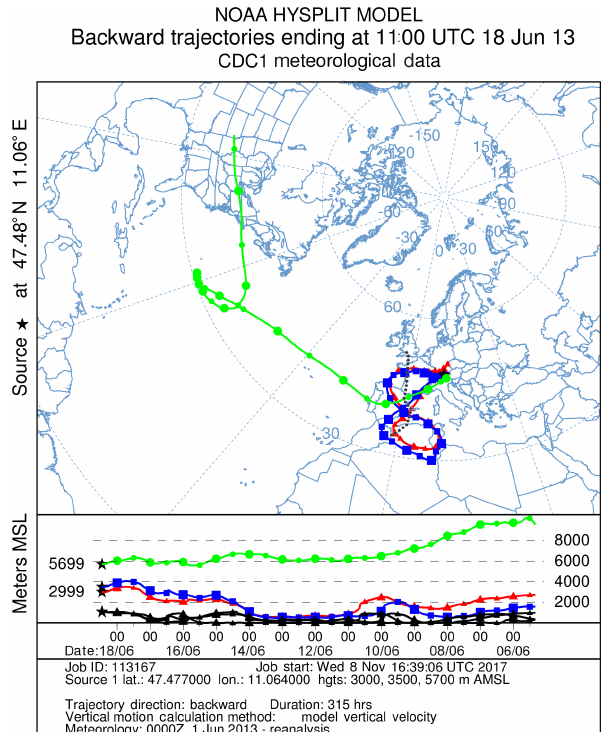
Figure 8. Selected HYSPLIT 315h backward trajectories start- ing above Garmisch-Partenkirchen on 18 June 2013 at 11:00UTC (12:00CET) within the Saharan dust layer as well as in stratospheric intrusion at 5.7km (see Fig. 5); the black curves at the bottom of the vertical cross section mark the ground levels for each trajectory. The dotted black line indicates the arriving cold front on 18 June 2013,